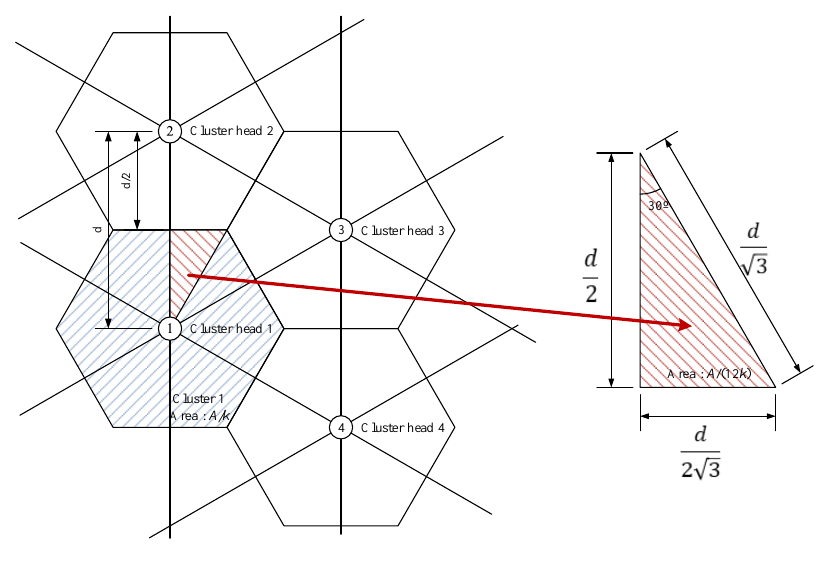
Figure A1. Cluster